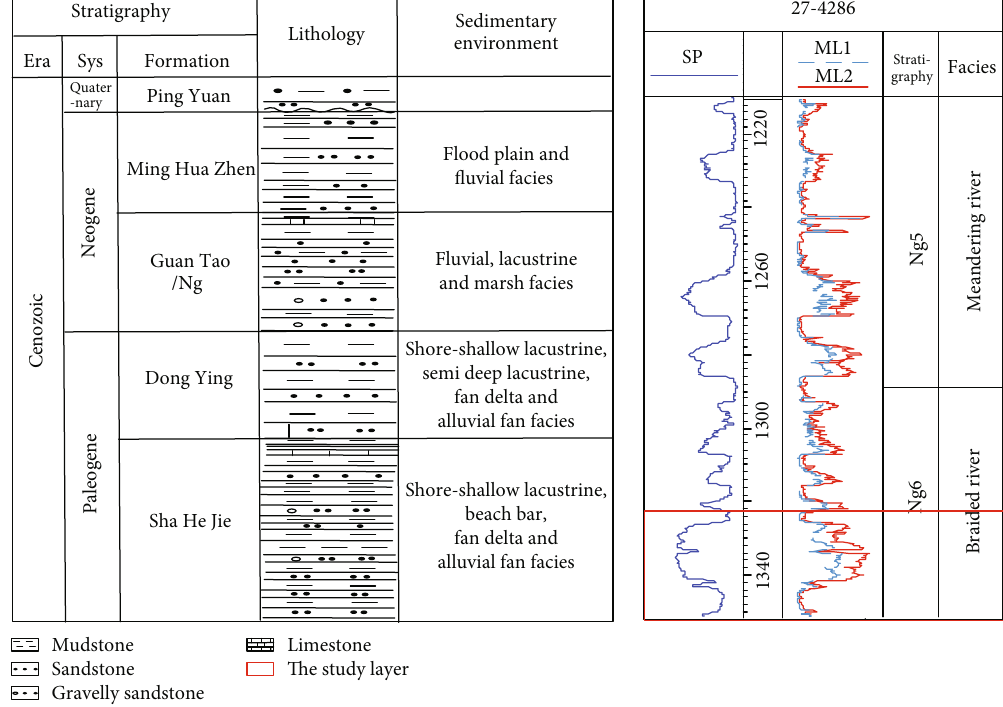
Figure 2: Characteristics of Stratigraphy and Sedimentary environment. Sp: spontaneous-potential; ML: